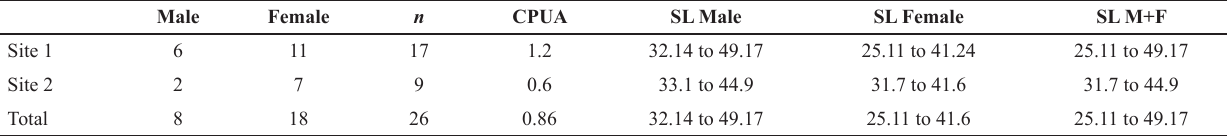
Table 2. Sex ratio, number of sampled specimens ( n ), CPUA (fishes/m 2 ), and standard length (SL in mm; minimum - maxi- mum) of A. cheradophilus between sampling sites in southern